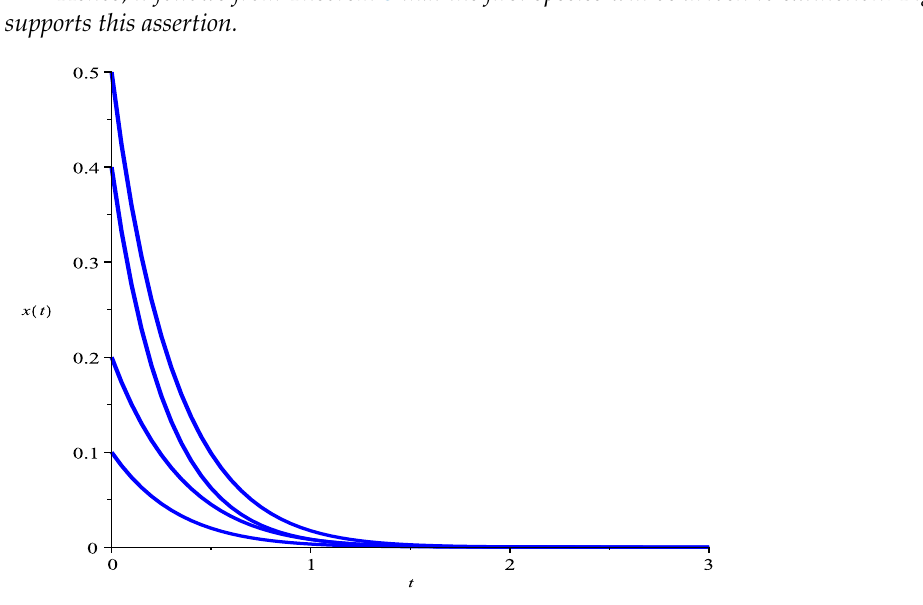
Figure 3. Extinction of the first species; here, we take a 1 = 3 + sin ( t ) , c 1 = 0.75 + 0.25cos ( t ) , which includes the initial conditions ( x ( 0 ) , y ( 0 )) = ( 0.5,2 ) , ( 0.4,0.02 ) , ( 0.1,0.4 ) , and ( 0.2,2 )